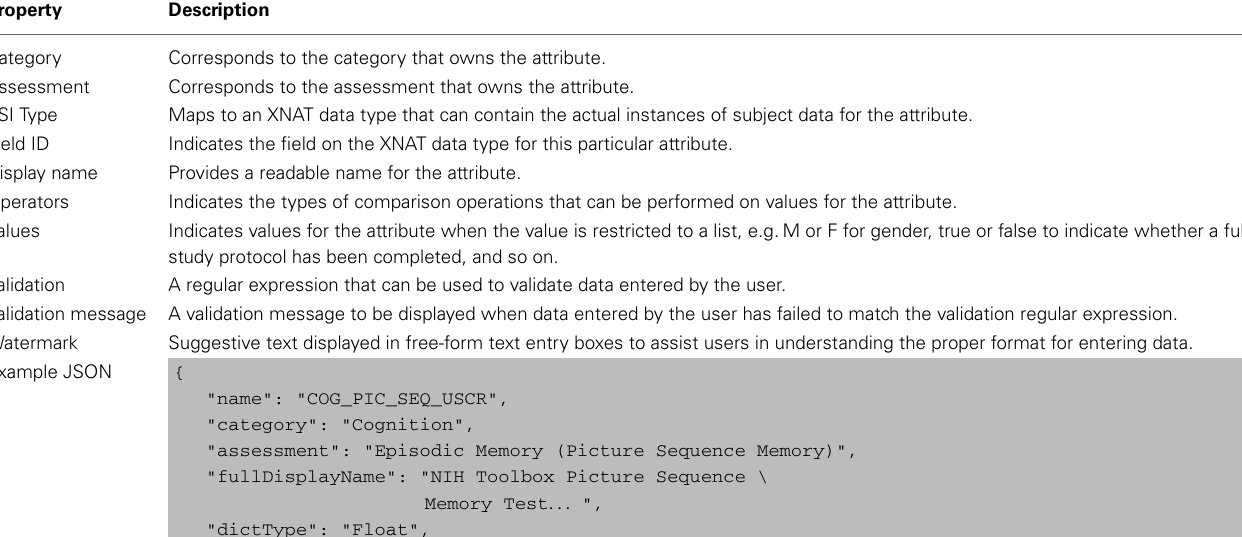
Table 4 | Defining attribute node-type properties in